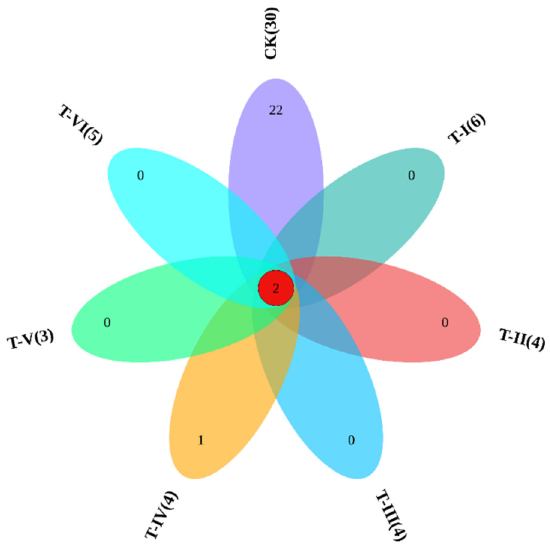
Figure 4. The Venn diagram showing common and unique OTUs in different samples.